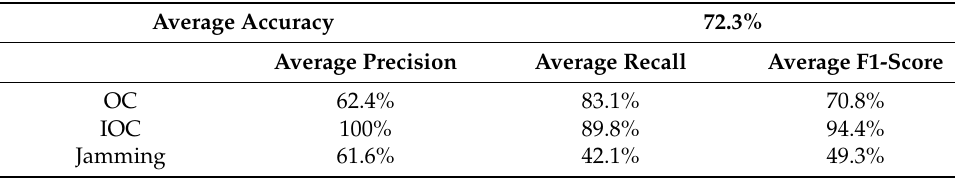
Table 9. k-NN Univariate Performance.